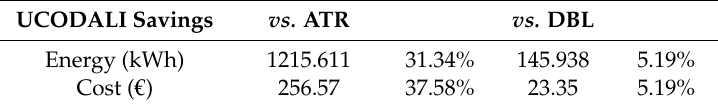
Table 4. Saving rates (energy and cost) for 1-year